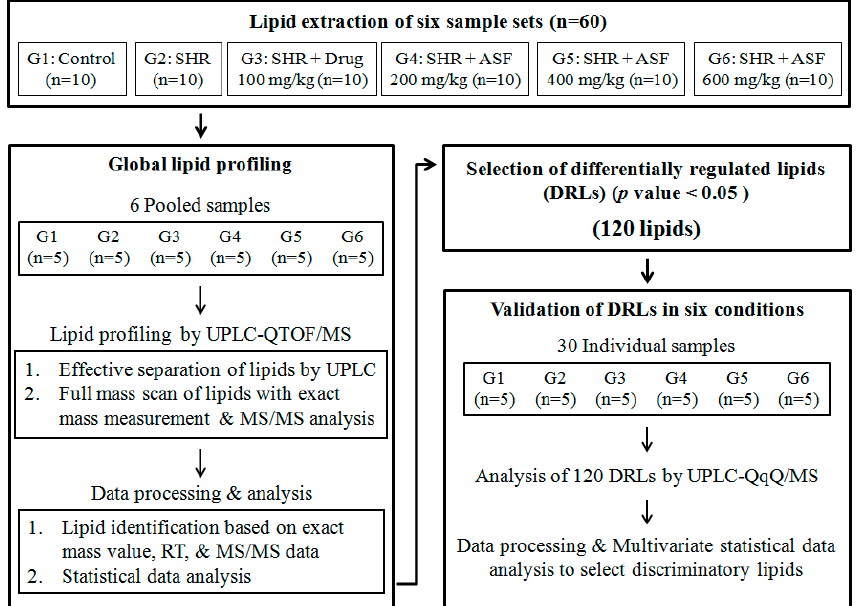
Figure 1. The overall scheme of the lipidomic analysis used to find the discriminatory lipids for six groups, including the normal control (G1), spontaneously hypertensive rats (SHR) (G2), SHR + Drug 100 mg / kg (G3), SHR + ASF 200 mg / kg (G4), SHR + ASF 400 mg / kg (G5), and SHR + ASF 600 mg / kg (G6).